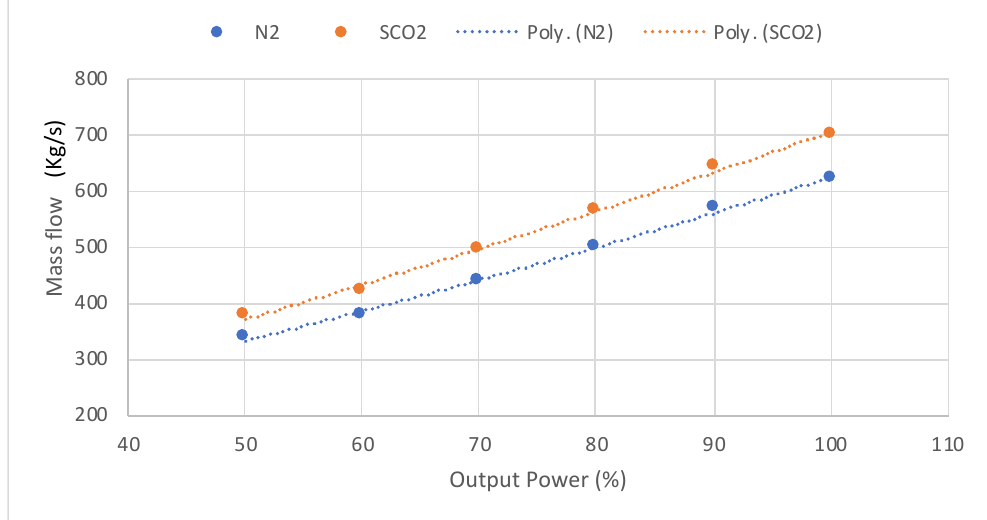
Figure 2. Mass-flow-rate demand of nitrogen and super-critical carbon dioxide cycles when producing electricity, between 100% and 50% power demand. The debited mass-flow rate is utilised for hydrogen production via a control valve as part of a system, which detects signals based on grid-power demand.